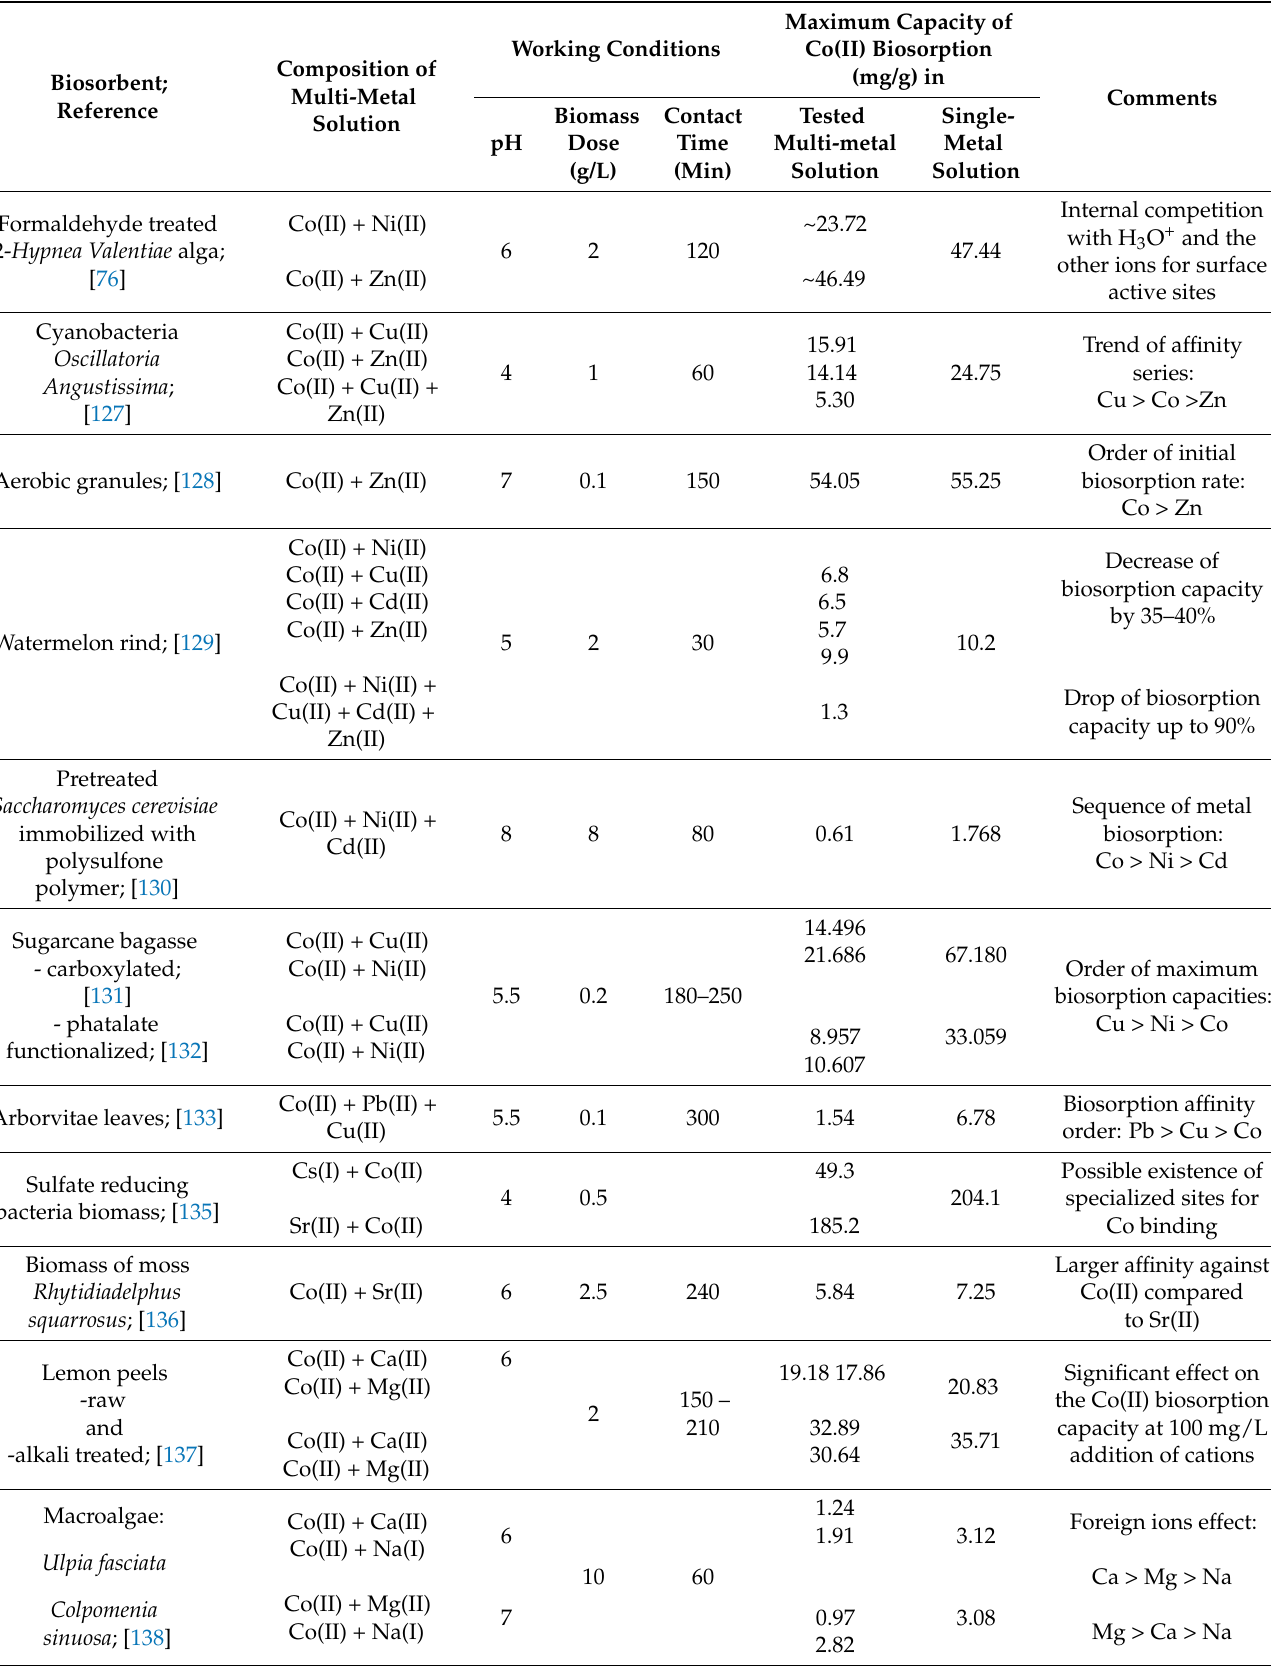
Table 4. Batch biosorption systems for Co(II) retention from polymetallic synthetic